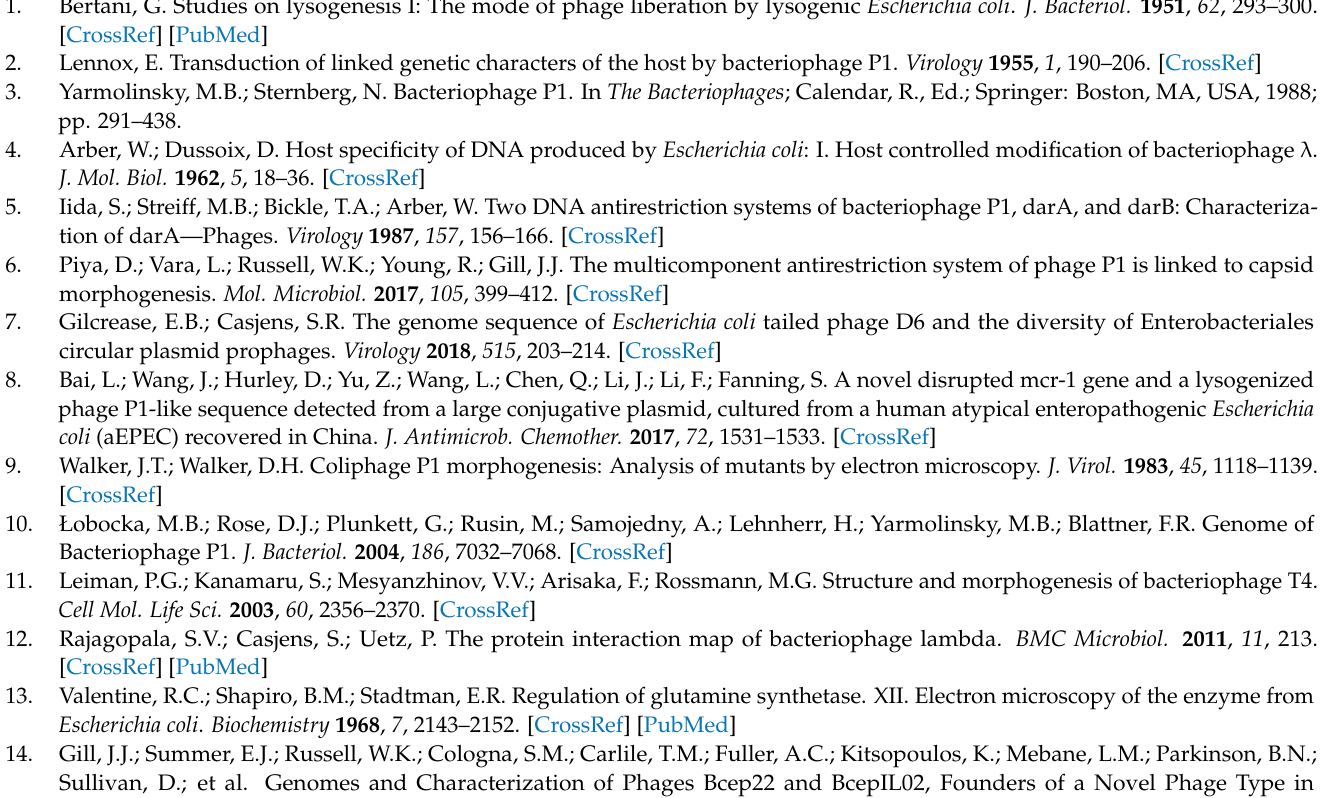
Table S5: Baseplate components of coliphage T4 compared to